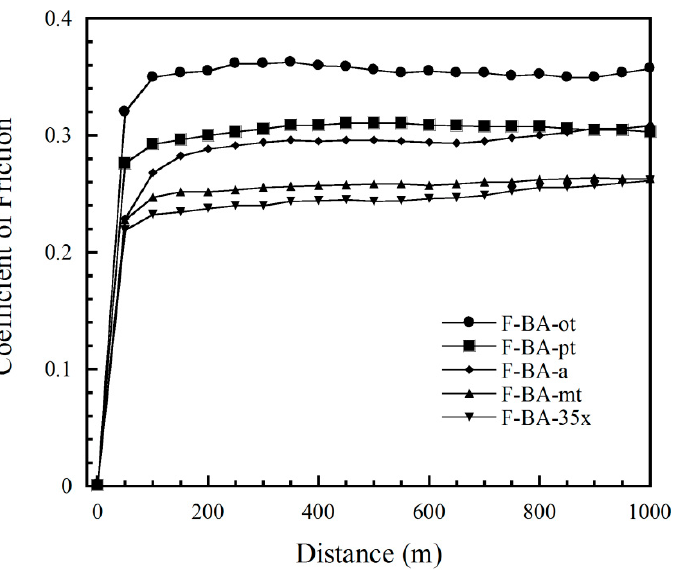
Figure 5. Coefficient of friction (COF) at 25 °C of polybenzoxazine composites prepared from different benzoxazine resins.